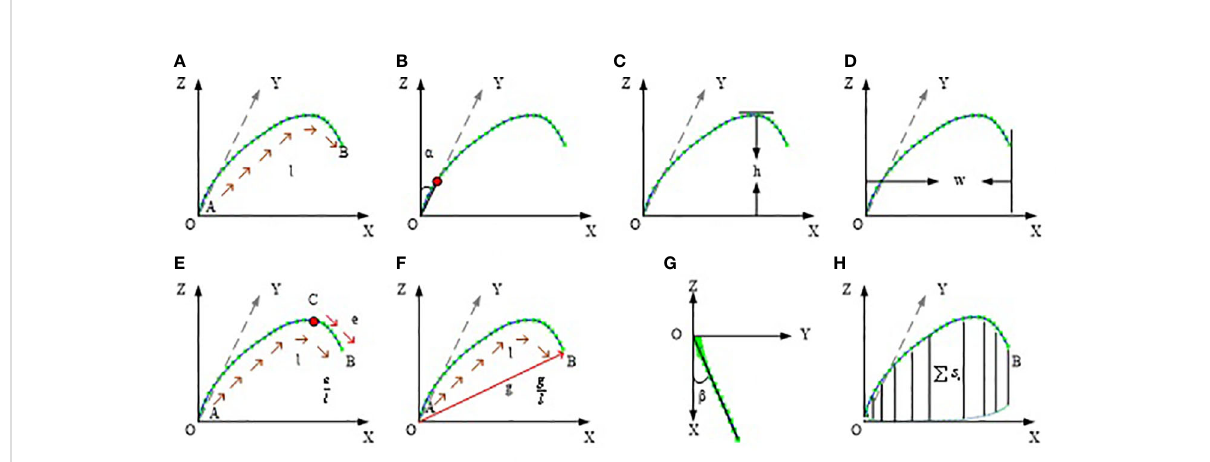
FIGURE 4 Schematic diagram of leaf midrib phenotypic traits. (A) leaf length, (B) leaf angle, (C) leaf upward growth height, (D) leaf horizontal growth length, (E) upper leaf midrib sag, (F) leaf midrib curvature, (G) leaf midrib deviation, (H) leaf midrib space occupied